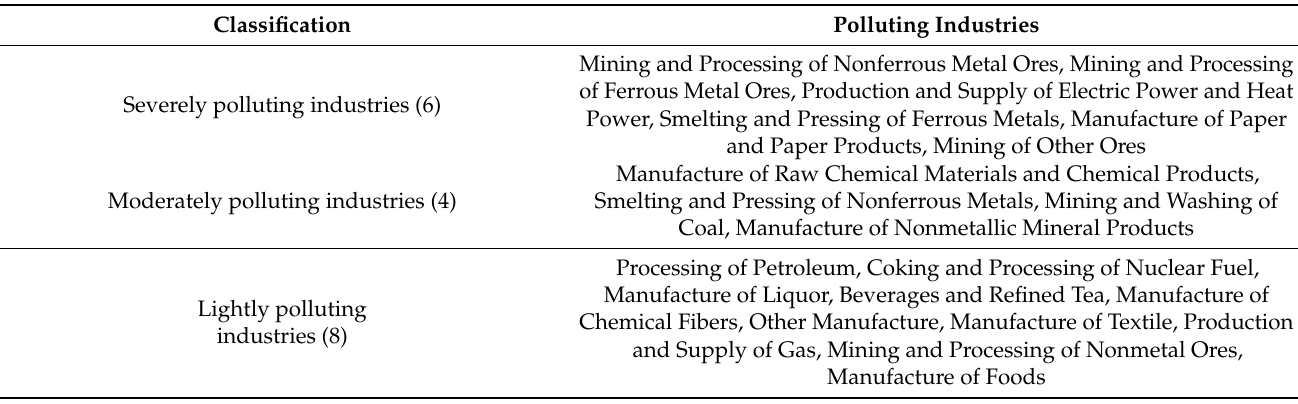
Table 2. Classification of polluting